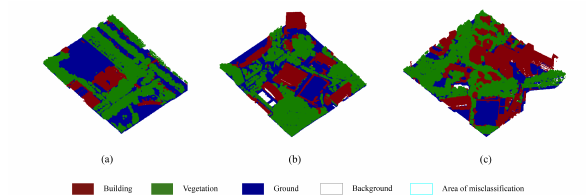
Table 3. Quantitative evaluation of the supervoxel-based results and point-based results of the proposed method on the Shenzhen airborne LiDAR dataset.